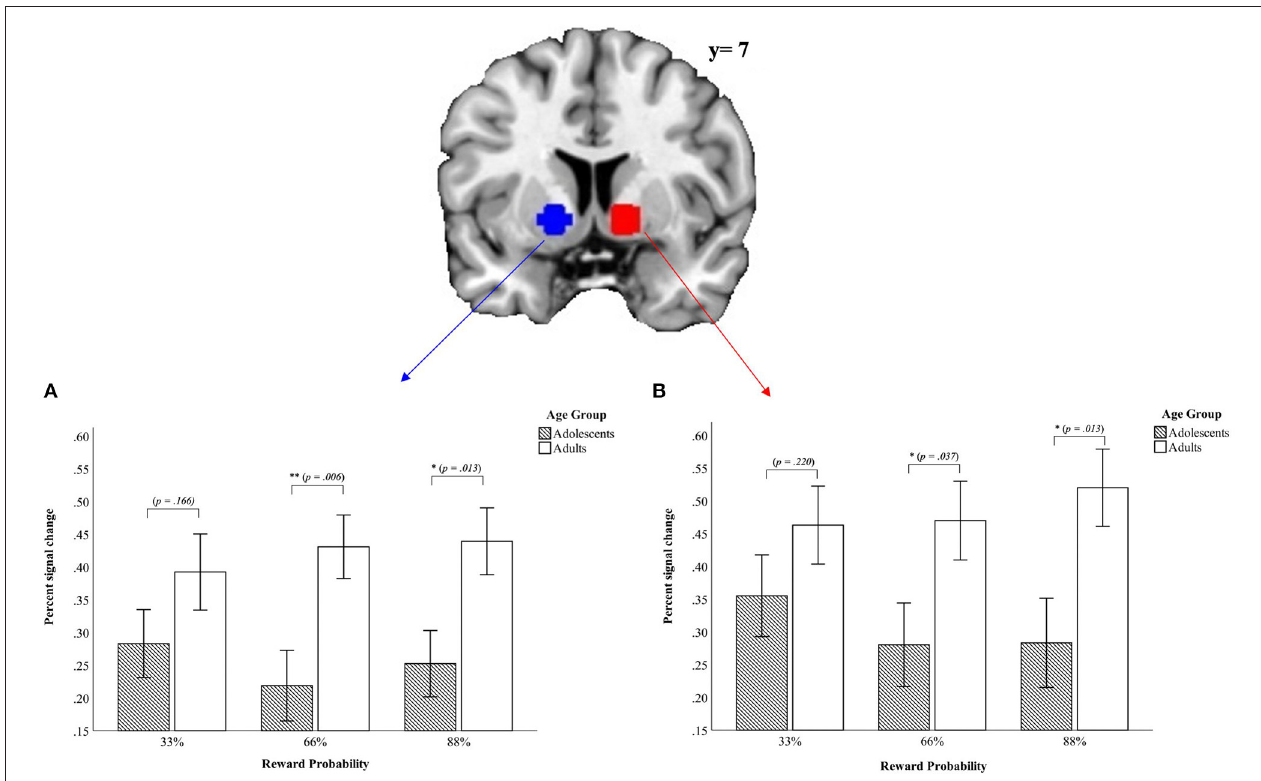
FIGURE 3 | Mean values of percent signal change in the ROI for left (A) und right (B) VS from the signal difference monetary vs. verbal condition ( p < 0.05, corrected cluster level, k > 10). Error bars denote ± 1 SE. * p ≤ 0.05; ** p ≤